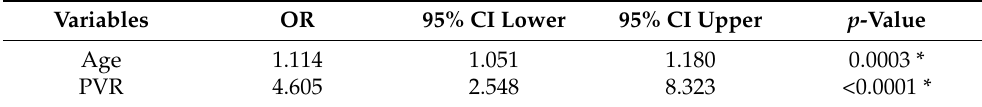
Table 5. Multivariate logistic regression analysis of rPAH